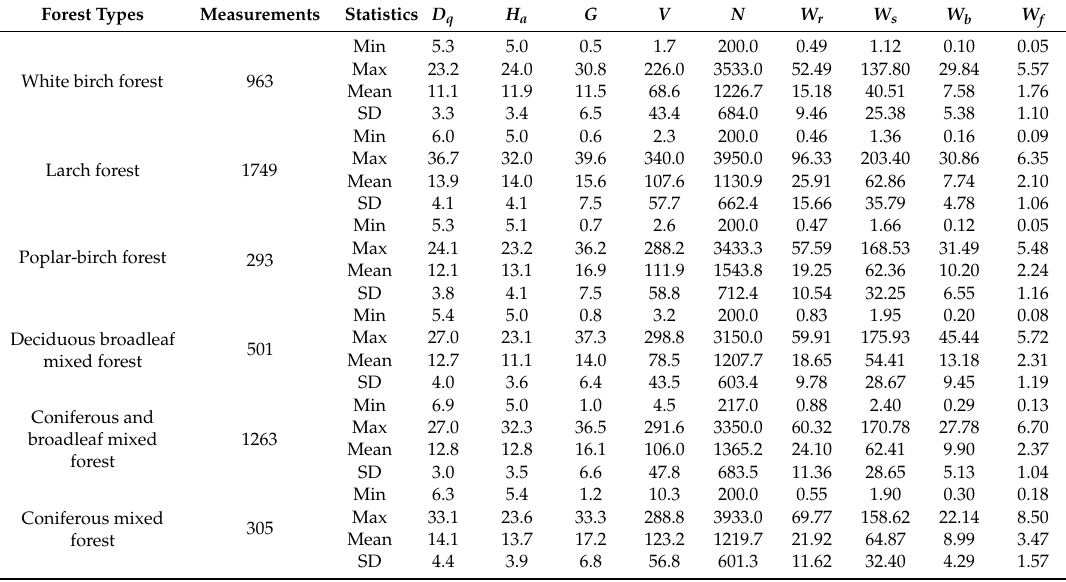
Table 1. Summary statistics of stand variables and biomass components for the six forest types in the Eastern Da Xing’an Mountains, Northeast